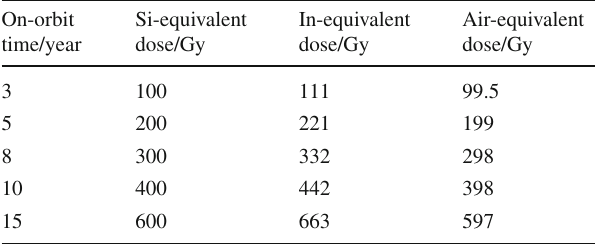
Table 1 Different dose conversion